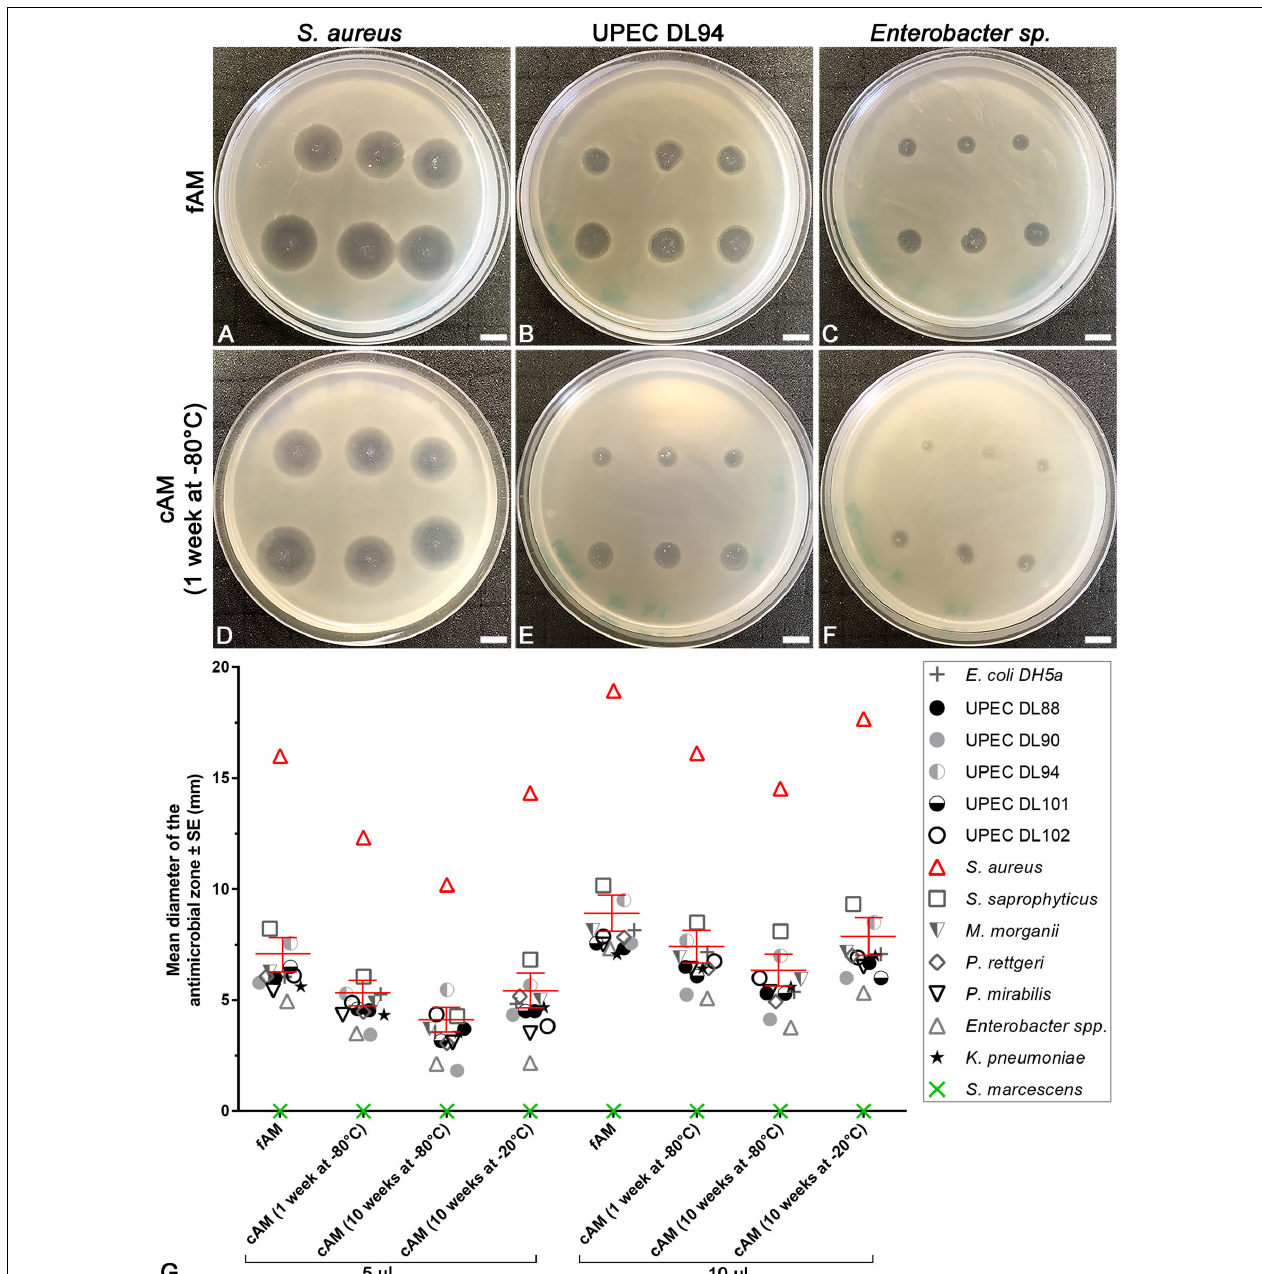
FIGURE 6 | The range of antimicrobial effect of fresh (fAM) and cAM homogenates varies between tested strains. (A–F) Homogenates of fAM and cAM have antimicrobial effect on S. aureus , UPEC DL94 and Enterobacter sp. The range of antimicrobial effect of fAM and cAM (1 week at –80 ◦ C) homogenates varies, namely between strong ( S. aureus )/moderate (UPEC DL94)/minor ( Enterobacter sp.) antimicrobial effect. Furthermore, fAM homogenate inhibits the growth of tested strains (A–C) , while cAM (1 week at –80 ◦ C) homogenate inhibits the growth of S. aureus and decreases the growth of UPEC DL94 and Enterobacter sp. (D–F) . The quantity of fAM and cAM (1 week at –80 ◦ C) homogenates used was 5 µ l (upper rows) and 10 µ l (lower rows). Scale bars: 10 mm. (G) The average antimicrobial effect of fAM and cAM homogenates on all tested strains. Larger volumes of homogenates (10 µ l) have greater antimicrobial effect than smaller volumes (5 µ l). For fAM each point represents the mean diameter of the antimicrobial zone ± SE (mm) for three independent replications of experiments using three biological samples; each experiment was performed in six technical repeats for each strain. For cAM (1 week at –80 ◦ C) each point represents the mean diameter of the antimicrobial zone ± SE (mm) for four independent replications of experiments using four biological samples; each experiment was performed in three to six technical repeats for each strain. For cAM (10 weeks at –80 ◦ C) each point represents the mean diameter of the antimicrobial zone ± SE (mm) for five independent replications of experiments using five biological samples; each experiment was performed in six technical repeats for each strain. For cAM (10 weeks at –20 ◦ C) each point represents the mean diameter of the antimicrobial zone ± SE (mm) for one to three independent replications of experiments using one to three biological samples; each experiment was performed in three to six technical repeats for each strain. Bars in red represent the mean diameter of the antimicrobial zone ± standard error (mm) of all tested strains.